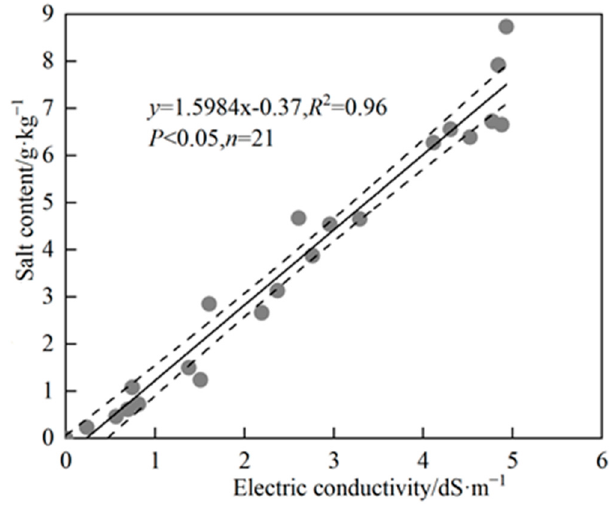
Figure 5. Relationship between soil salt content and conductivity ( EC 1:5